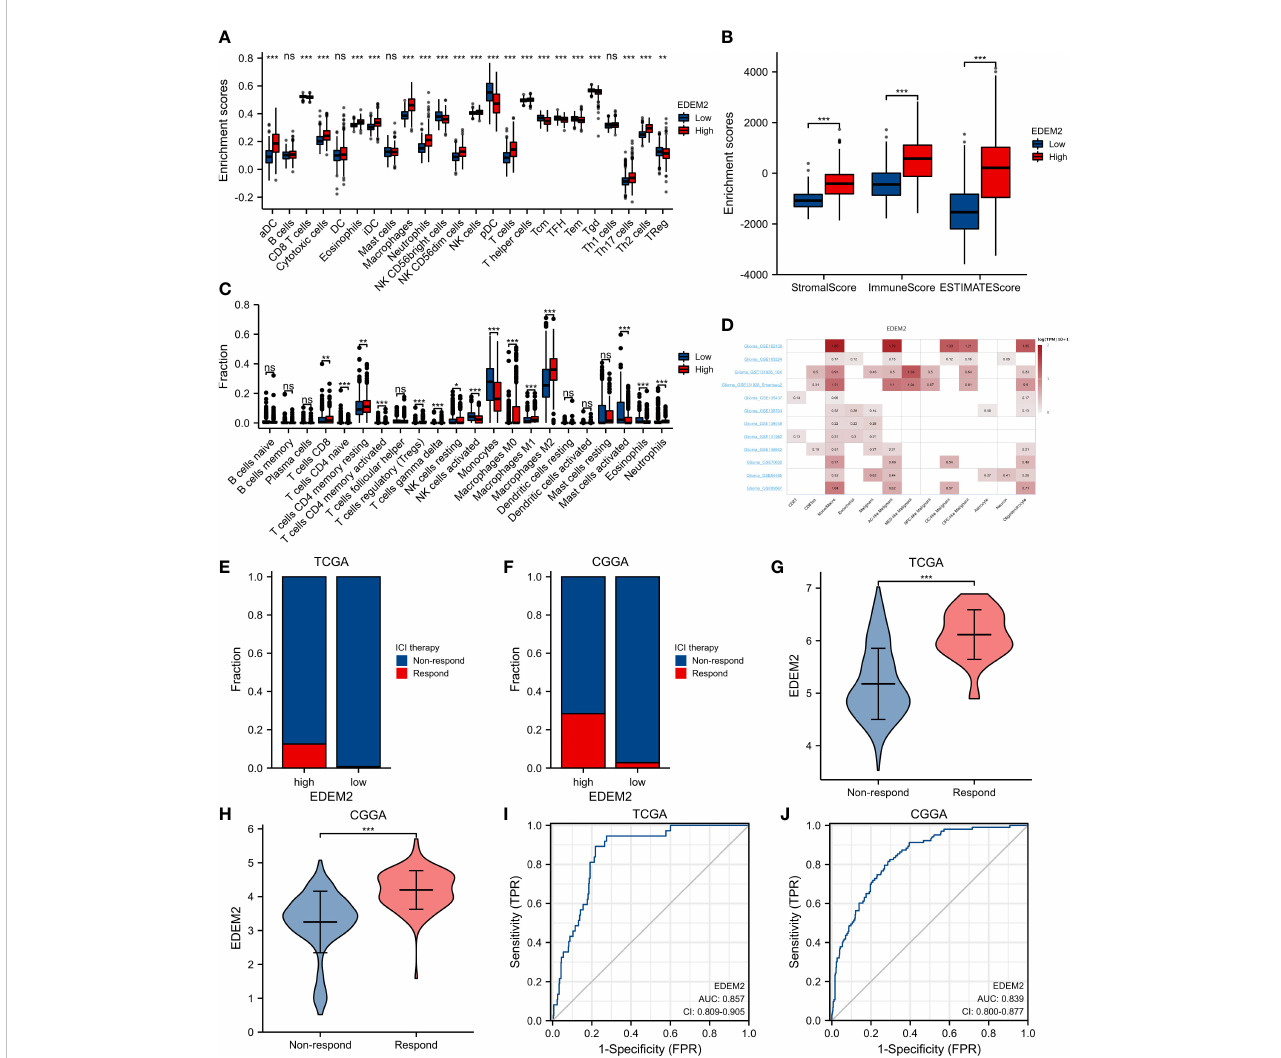
FIGURE 6 Analysis of immune in fi ltration and analysis of responsiveness to ICI treatment. (A) Immune in fi ltration by ssGSEA algorithm. (B) Immune in fi ltration by ESTIMATE algorithm. (C) CIBERSORT algorithm occupancy of immune cells. (D) Results of single-cell transcriptome analysis of EDEM2 based on the TISCH website. (E, F) ICI therapy responder distribution in different EDEM2 subgroups. (G, H) EDEM2 differences between responders and non- responders in the CGGA and TCGA cohorts. (I, J) ROC curve analysis of EDEM2 predicts ICI treatment response in the CGGA and TCGA cohorts. ns, p ≥ 0.05; *p< 0.05; **p<0.01;